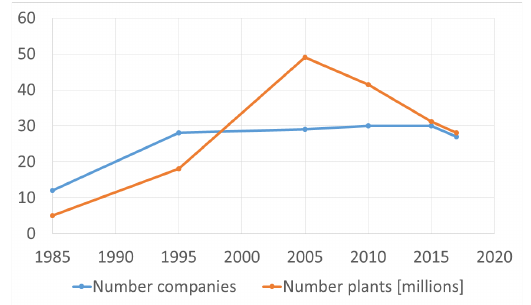
Fig. 1: Plant production via micropropagation in Germany from 1985 to 2017. Number of companies and number of plants (stated by ADIVK members, voluntary